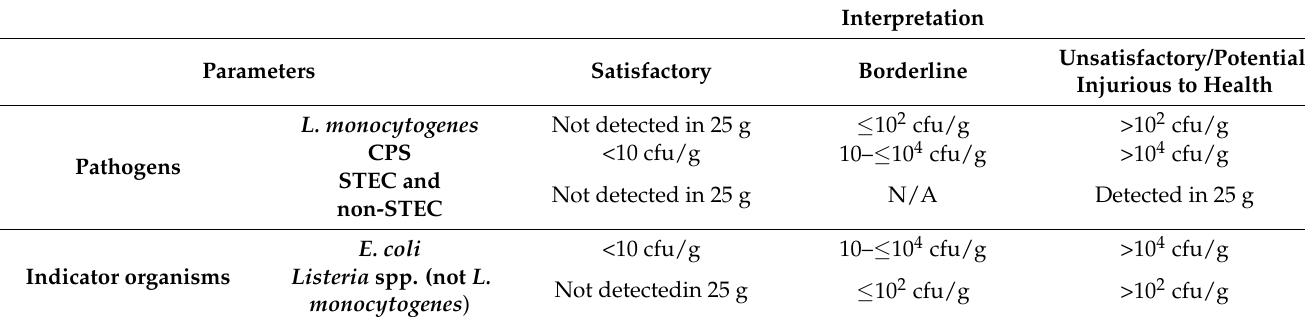
Table 1. Criteria for the interpretation of microbiological results according to the selected